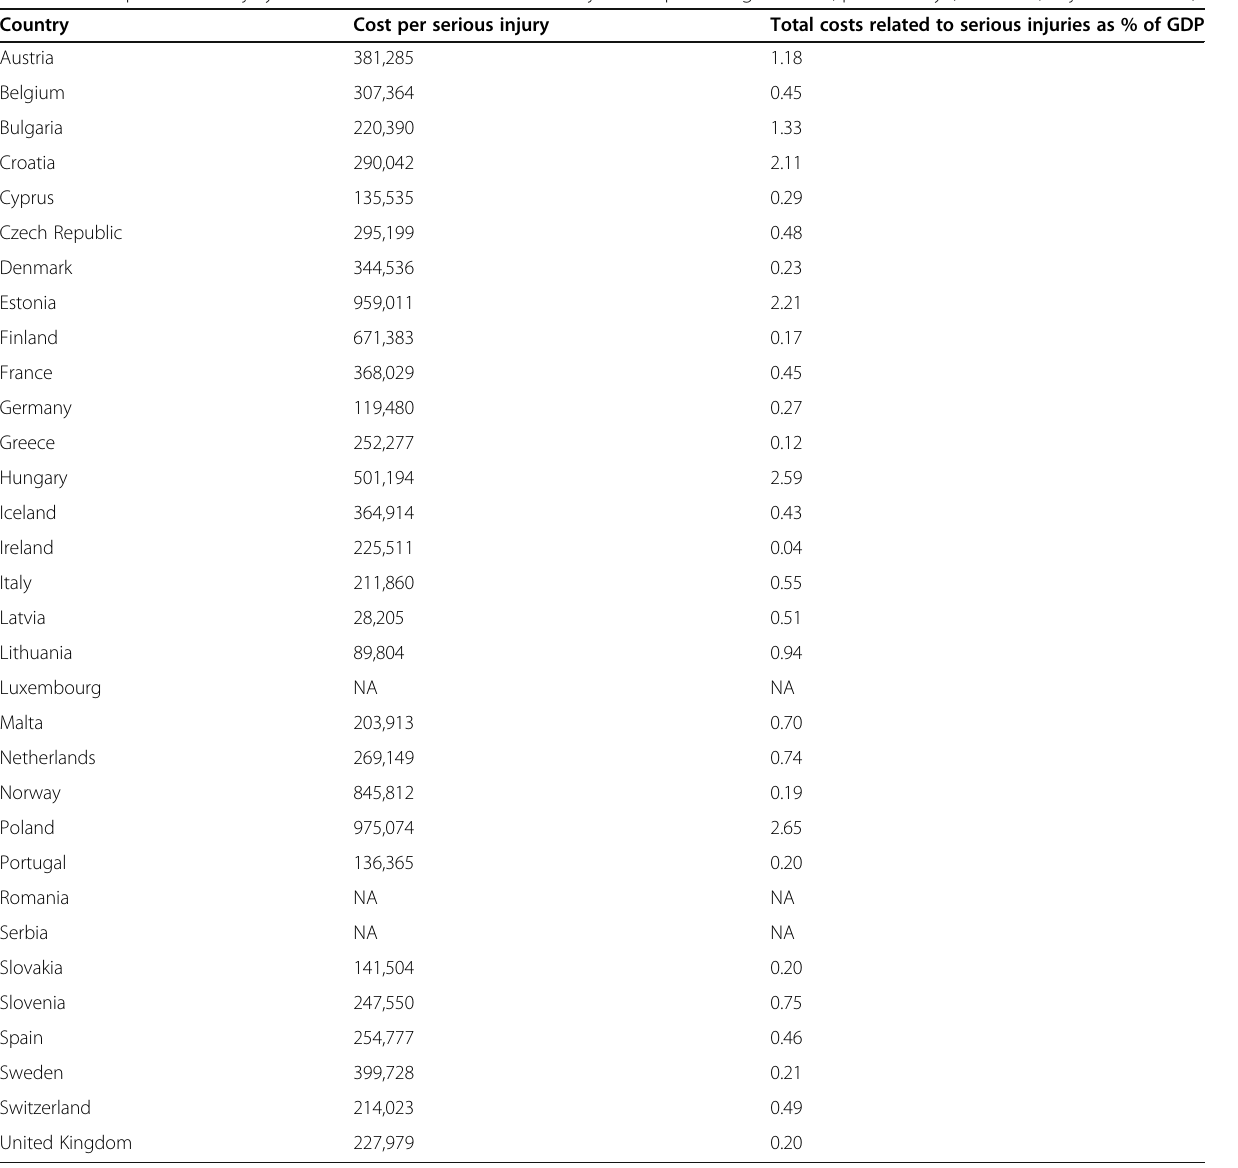
Table 1 Cost per serious injury and total costs related to serious injuries as percentage of GDP, per country (EUR 2015, adjusted for PPP)